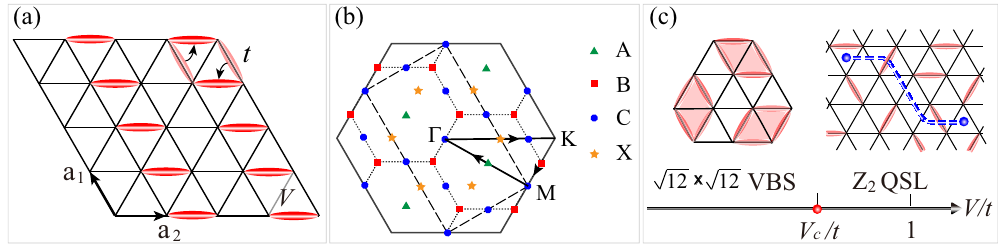
Fig. 1 Schematic diagram of quantum dimer model on triangular lattice. a The triangular lattice QDM. The two terms in the Hamiltonian Eq. (1) are depicted. The primitive vectors a 1 and a 2 are shown. The columnar reference dimer con fi guration for the measurement of vison correlations is also shown. b The solid hexagon and dashed rectangle are the Brilliouin zone (BZ) for the dimer and vison correlations, respectively, with Γ − M − K − Γ the high symmetry path for the former and A − B − C − X − A for the latter. c Phase diagram of the triangular ffiffiffiffiffi p ffiffiffiffiffi p ´ 12 12 VBS phases 18 . Approaching the V c from the Z 2 lattice QDM. The V = 1 is the RK point and the V c = 0.85(5) separates the Z 2 QSL and QSL, the dimer and vison-convolution spectral functions close gap at the X ( M ) points and correspondingly the vison spectra close gap at ffiffiffiffiffi p ffiffiffiffiffi p B point. (Insets) The enlarged unit cell of the ´ 12 12 VBS is shown, with its BZ the dashed hexagon in b . A pair of visons in the QSL phase, with a string presenting an arbitrary path chosen to evalue the vison correlation function C v ( r i , j